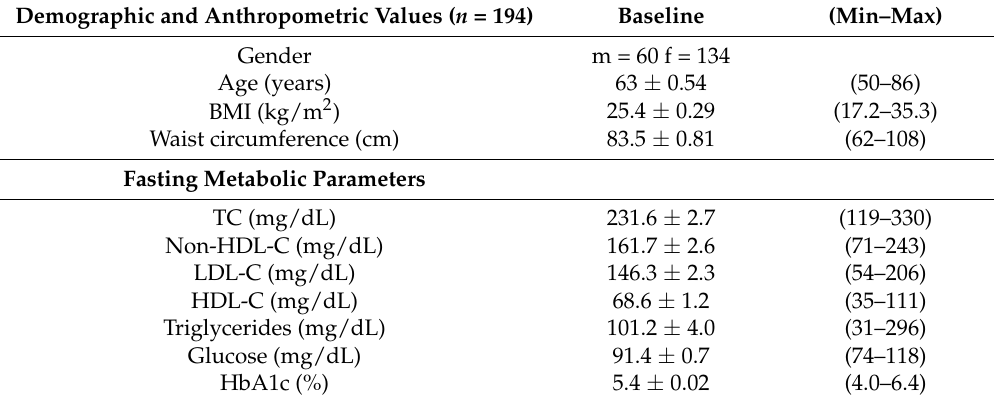
Table 1. Baseline characteristics of all study